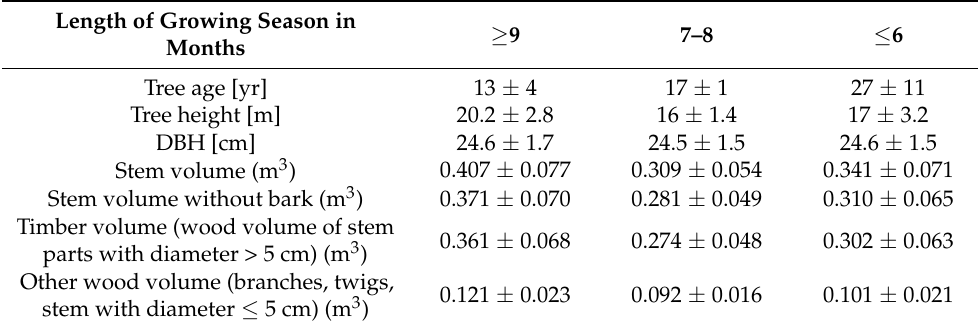
Table 2. Tree data (average ± standard deviation) from the three groups of different lengths of growing season. Thereby, the initial tree data for the length of growing season of ≥ 9 months, 7–8 months, and ≤ 6 months came from the trees with a DBH of 22 cm to 27 cm from Jalalabad, Chui, and Issyk Kul Province, respectively.